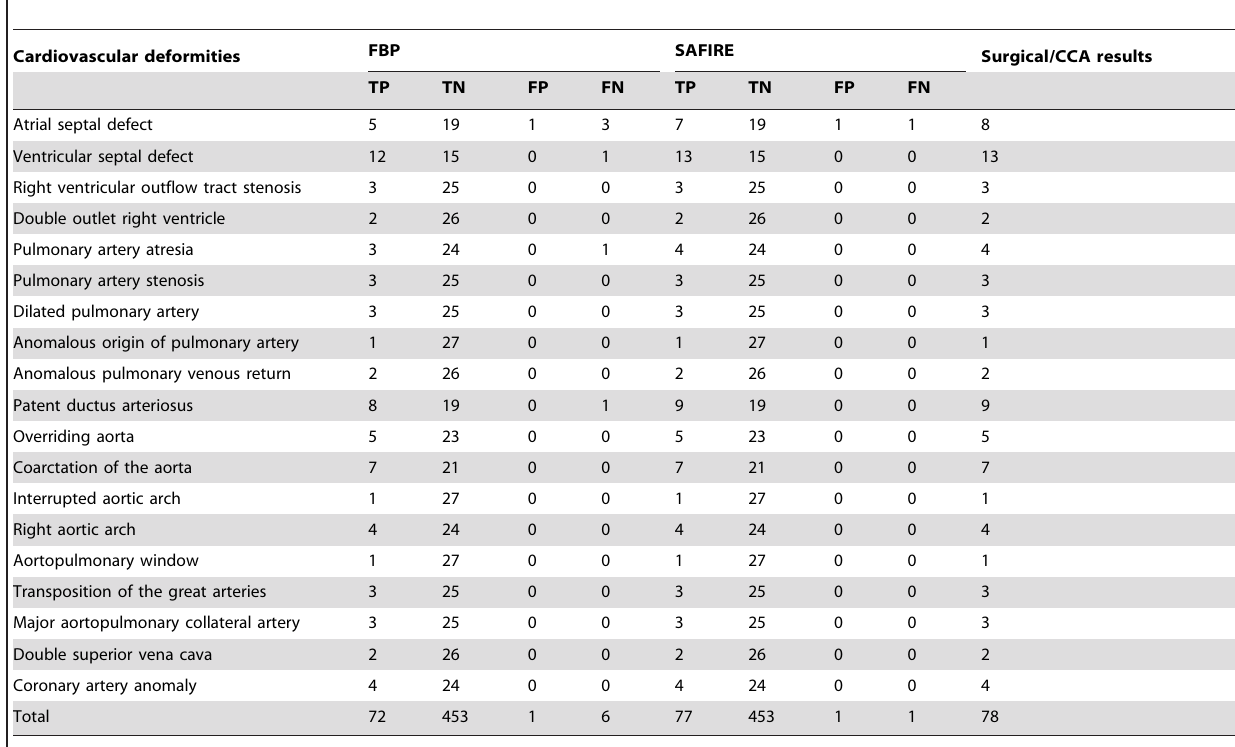
Table 4. Findings by filtered back projection (FBP) and sinogram affirmed iterative reconstruction algorithm (SAFIRE) series at 70 kVp dual-source CT (DSCT)